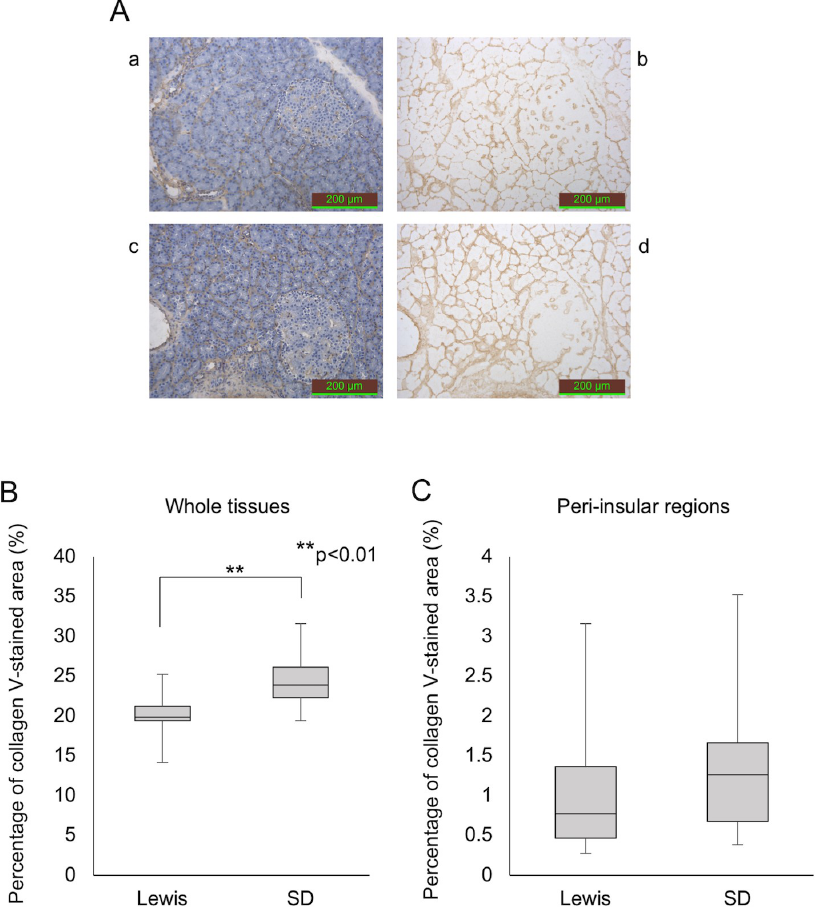
Fig 3. Anti-collagen V staining of the pancreatic tissues in each rat strain. (A) Anti-collagen V staining (a and b: Lewis rat; c and d: SD rat). The stained area was calculated using pictures without hematoxylin staining (b, d). (B) The percentage of the overall anti-collagen V-stained area. (C) The percentage of the anti-collagen V-stained area in the peri-insular region only.